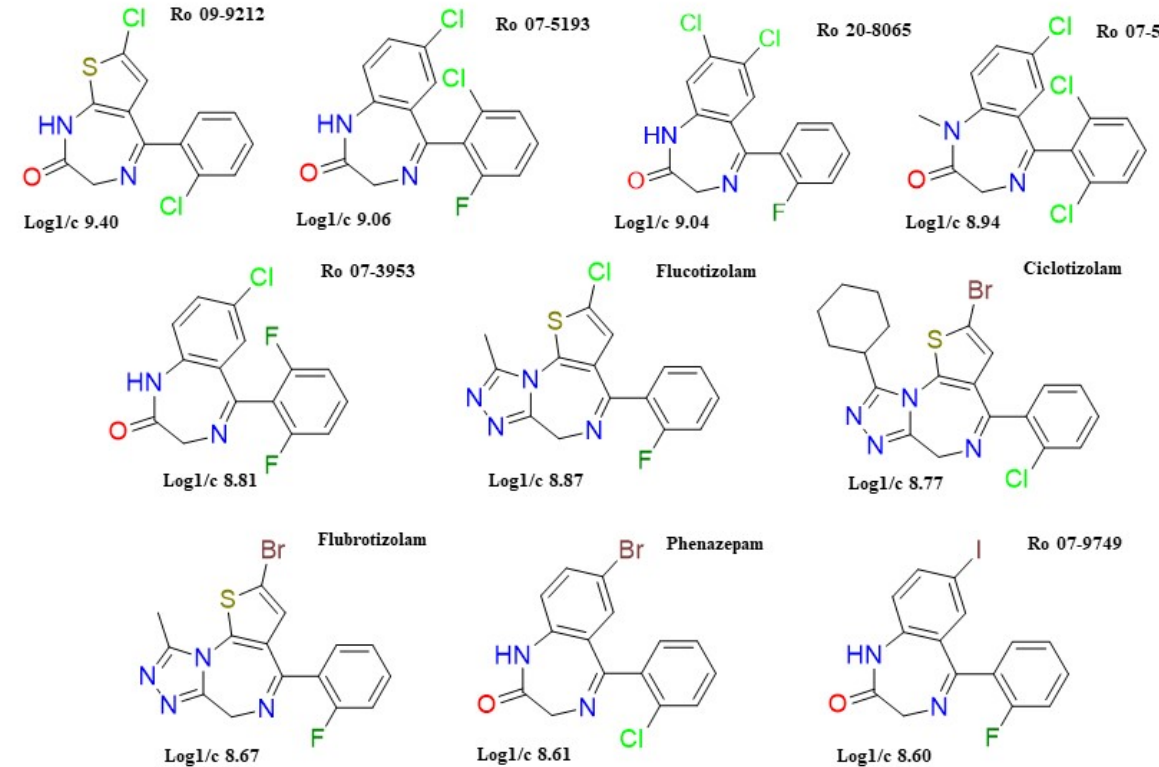
Figure 3. 2D structures of the first ten molecules ranked according to predicted log1/c values. Colours have been used to facilitate the identification of heteroatoms (Br, Cl, I, N, O, S) in the chemical structures. The 2D structures were built with the use of ChemDraw Plus 12.0.